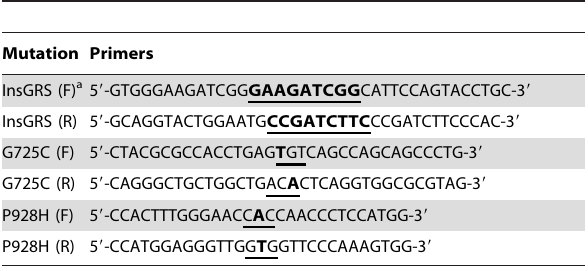
Table 2. Primers used for the creation of mutant hLGR6 by site-directed mutagenesis.